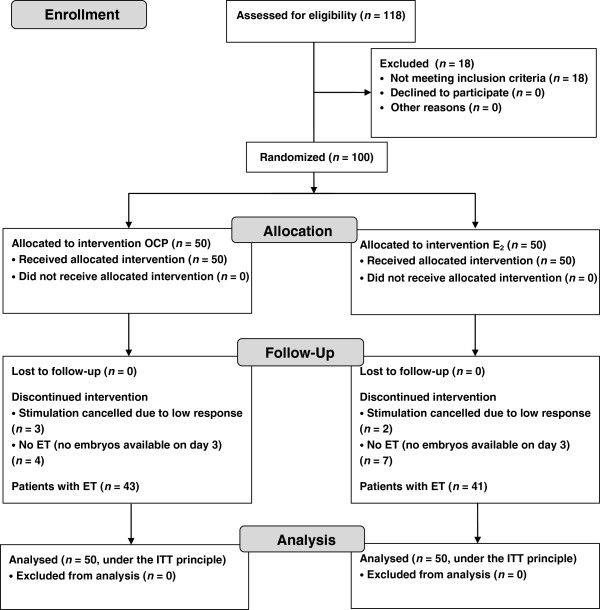
CONSORT 2010 flowchart. Note: ITT = intention-to-treat.